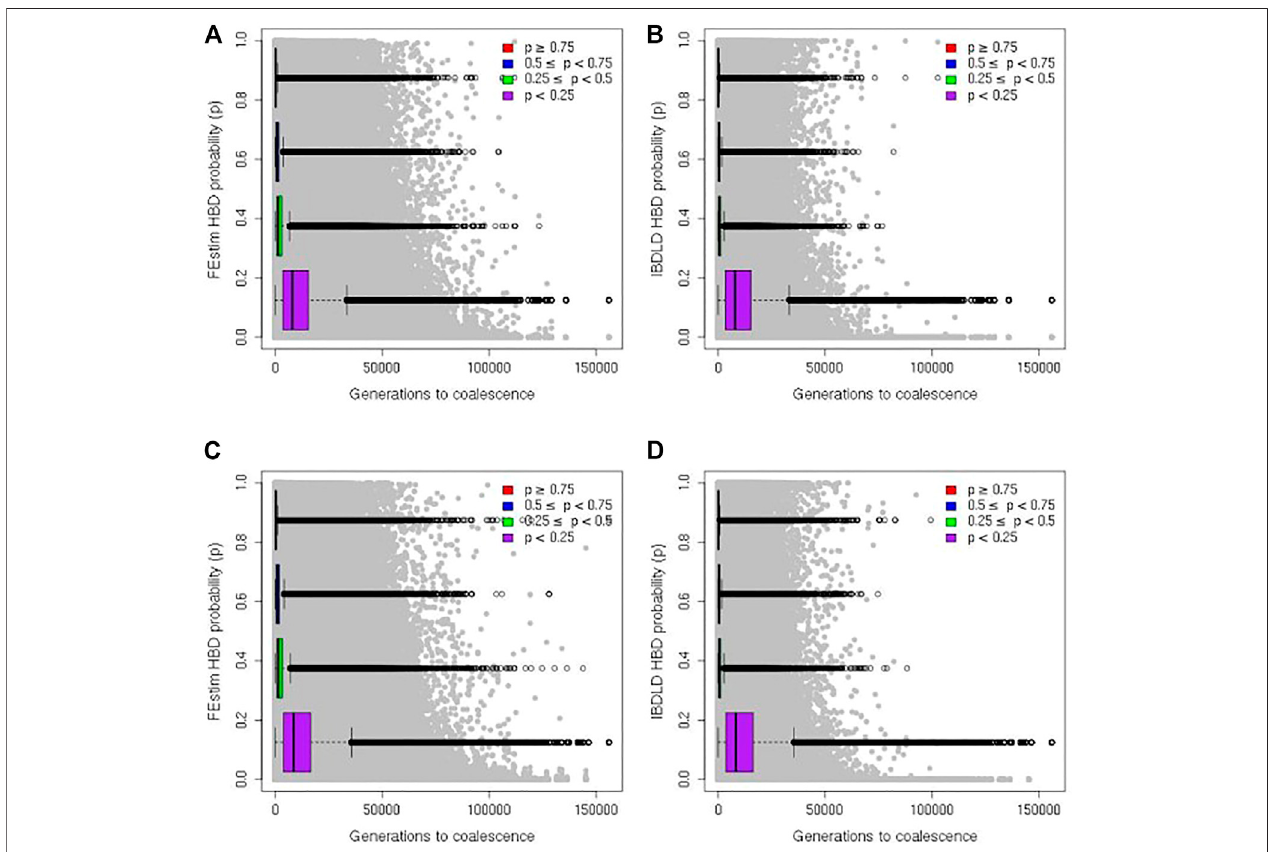
FIGURE6| Genomichomozygositybydescent(HBD)andgenerationtocoalescence.ScatterplotsofgenomicHBDprobabilitiesandgenerationstocoalescence from theobservedstudy and coalescent/genegenealogies.Resultsfromthe SLSJstudyareshown in (A) forFEstimand (B) forIBDLD. Results from theMontreal study are shown in (C) for FEstim and (D) for IBDLD. Boxplots show the distributions of generations to coalescence captured by setting different cutoffs of HBD probability to determine the HBD status of each SNP for each individual.